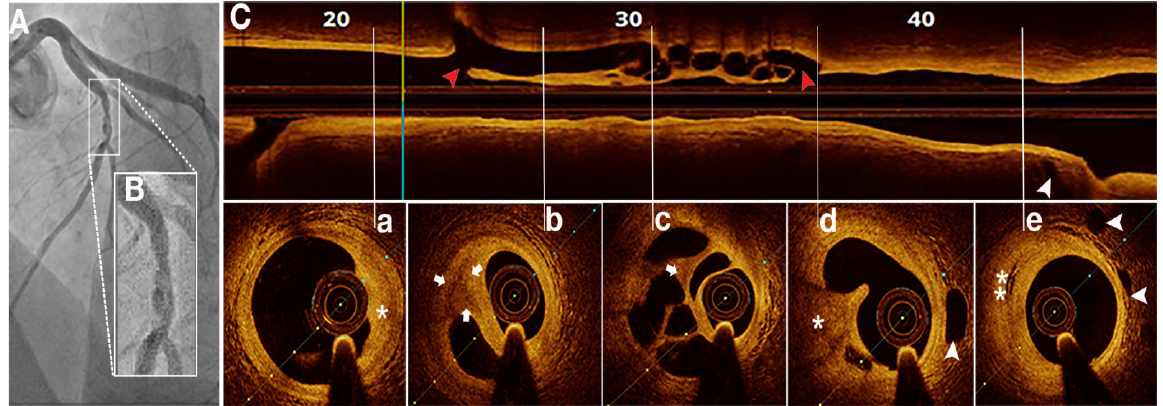
Figure 6. SRCT in a 43 years old female patient with unstable angina. ( A )—coronary angiography—braided filling defect on mid left anterior descending artery; ( B )—detailed angiographic view; ( C )—OCT—longitudinal view of SRCT (between the red arrowheads); ( a – e )—OCT—transversal views of SRCT with signs of atherosclerosis: atheroma infiltration (asterisk), hypervascularization (white arrowheads) and proteoglycan-rich tissue (white arrows). Drug eluted stent implantation was performed.